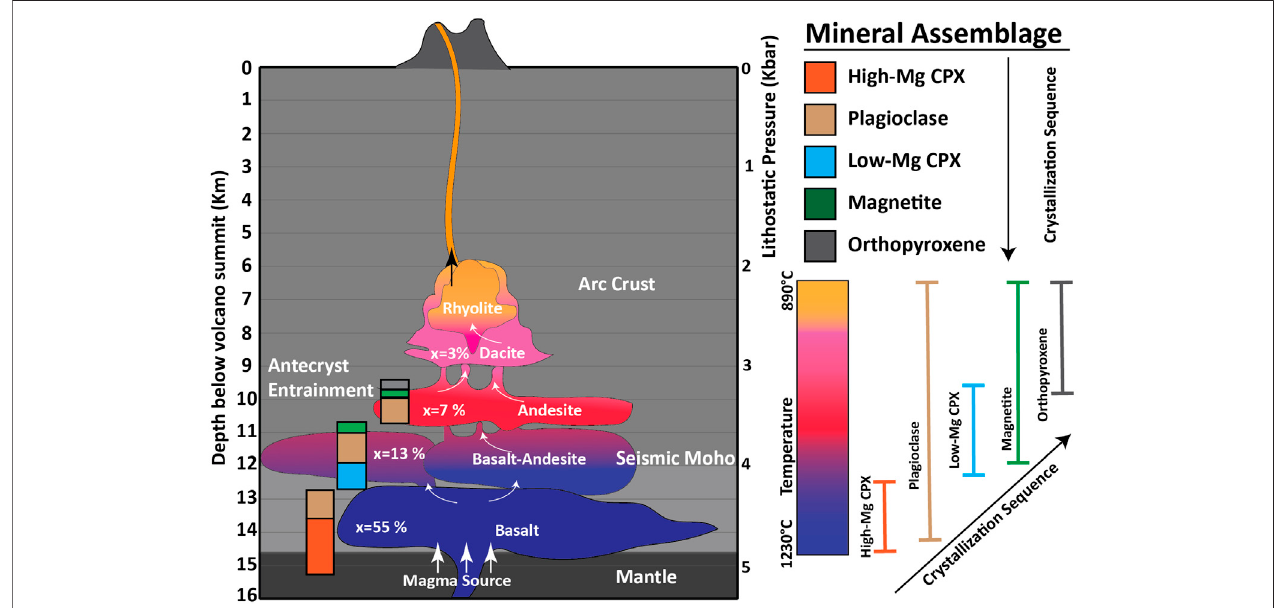
FIGURE 11 | Havre volcano magmatic plumbing system. This schematic section of the Havre magmatic plumbing system is scaled at depths and lithostatic pressure(determinedbythedensityofaverageoceaniccrust~2.9 g cm − 3 ;Ridol fi etal.,2010).Crystallizationandmeltevolutionfrombasalttorhyoliteprogressesdown pressure represented by stalling multiple magmatic lenses shown by multicolor gradients correlating to compositions and pressures from the rhyolite-MELTS model (basalt = blue; basaltic andesites = red to pink; andesite = green, dacite = pink to orange). Bar graphs depict the normalized proportion of minerals crystallized in each stepwise rhyolite-MELTS model from Table 3 . The multicolor bar to the right represents the temperature of the melt in the magmatic system correlating with pressure from the calculated liquidus (~1,250 ° C, 5 kbar) to the pre-eruptive magmatic conditions for the 2012 eruption (~890 ° C, 2 – 3 kbar; Knafelc et al., 2020). To